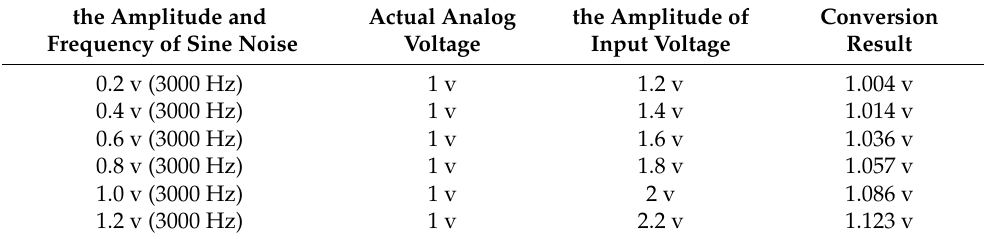
Table 3. The conversion results of the 1 V analog voltage with the sine noises.